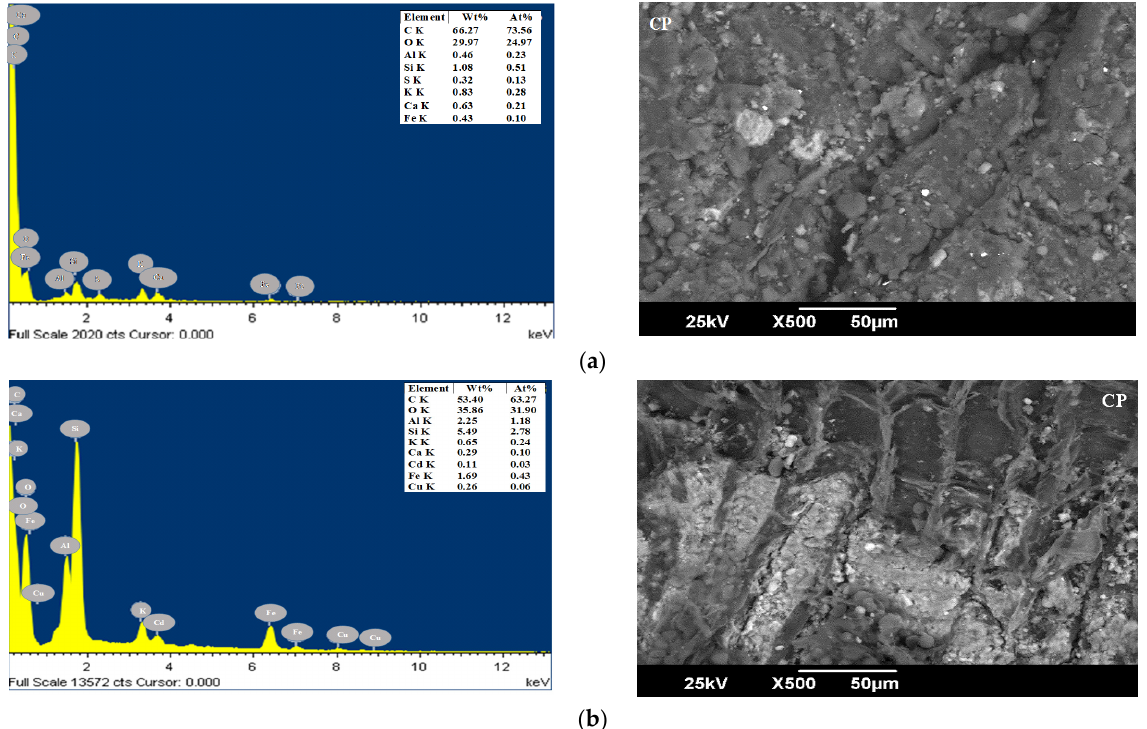
Figure 4. EDS spectra and -SEM micrographies for CP: ( a ) before and ( b ) after adsorption.